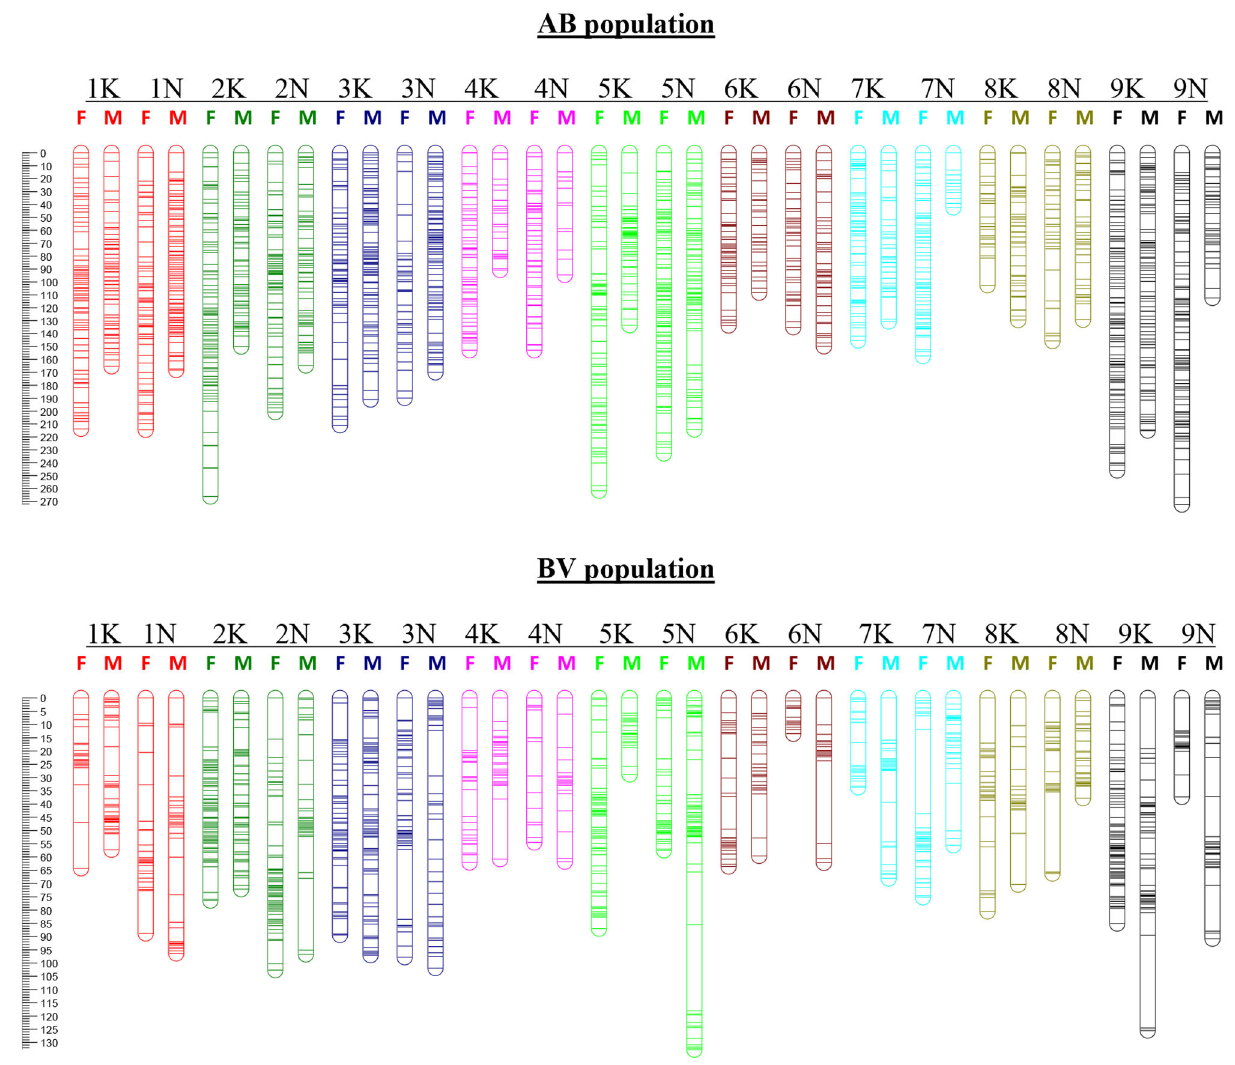
FIGURE 1 | Linkage and homology groups of maternal (F) and paternal (M) maps for the AB population (top) and BV population (bottom). Genetic distance (in Kosambi centiMorgans) is given on the left-hand side. Individual bars represent loci positions with thicker bars indicating two or more closely linked loci. The LGs (numbered 1K-9K and 1N-9N) are specified above the corresponding female and male